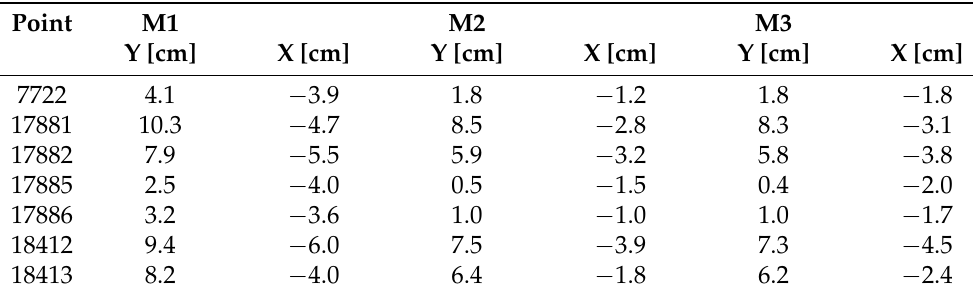
Table 5. Results of the different methods using all control points within 500 m around parcel 318: M1 (local transformation by 2D Helmert transformation already shown in Table 4), M2 (IDW based on residuals), and M3 (IDW based on homogeneous